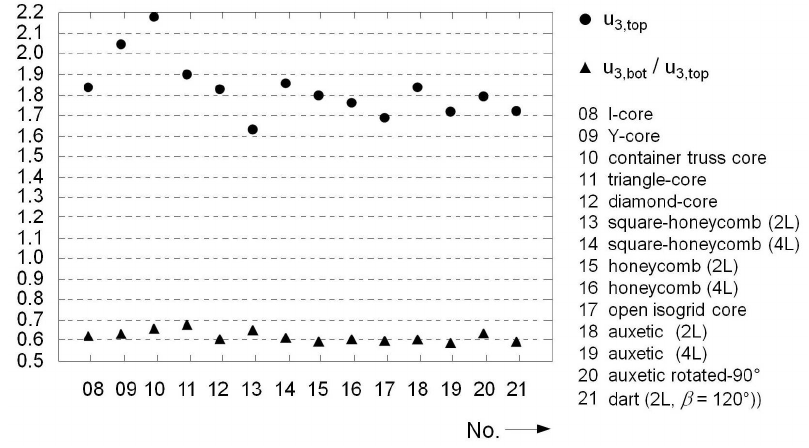
Figure 23. Prismatic cores: normalized maximum values for displacement u 3,top and displacement ratio u 3,top / u 3,bot .